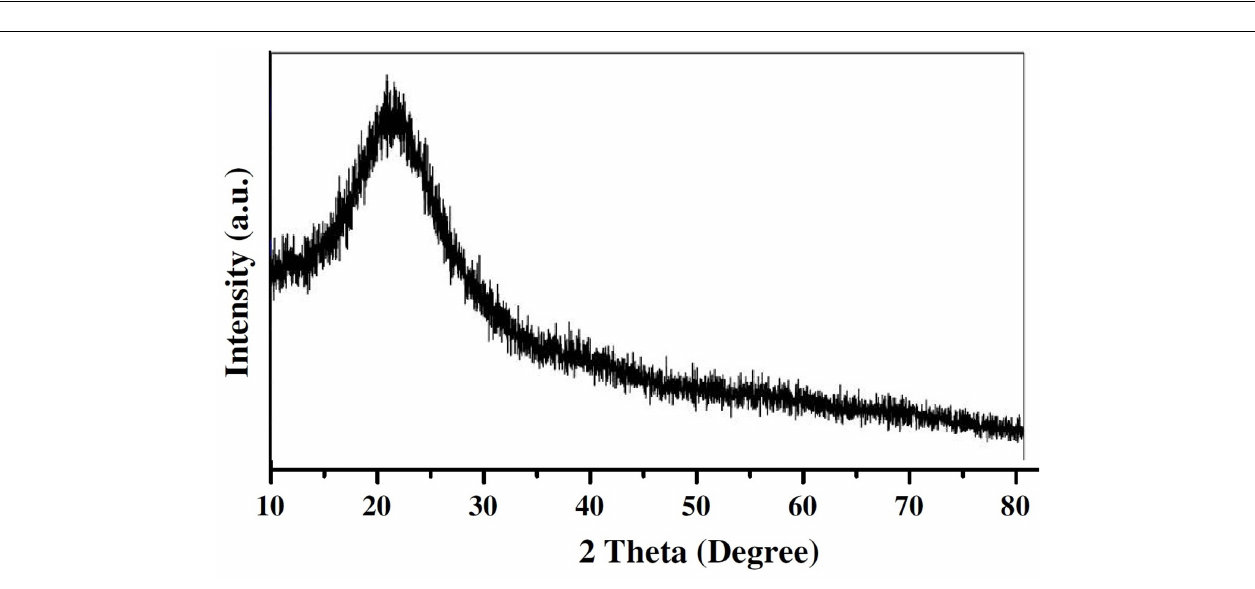
FIGURE 3 | High Resolution Transmission Electron Microscopy (HRTEM) and Energy dispersive X-ray spectroscopy profile of biochar particles and Cordyceps fumosorosea -Biochar nanoparticles.